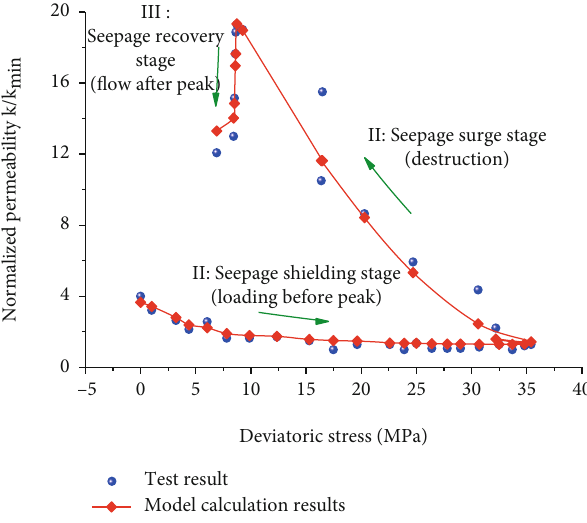
Figure 11: Veri fi cation of permeability model in the complete process of rock